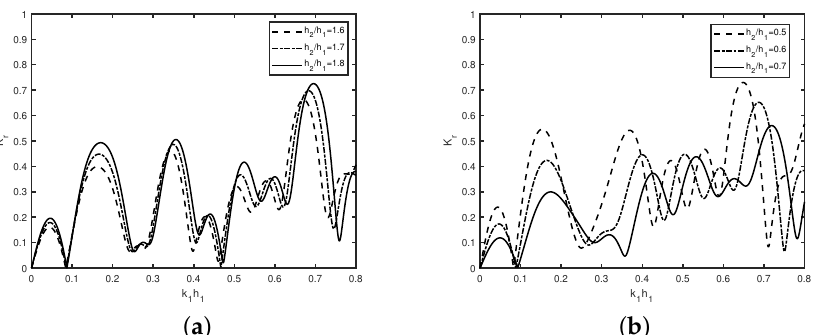
Figure 12. K r versus k 1 h 1 in case of different depth h 2 / h 1 of double ( a ) rectangular trenches with w / L 1 = 0.6, d / L 1 = 0.86; ( b ) breakwaters with w / L 1 = 0.35, d / L 1 = 0.6 in the presence of a semi-infinite plate.